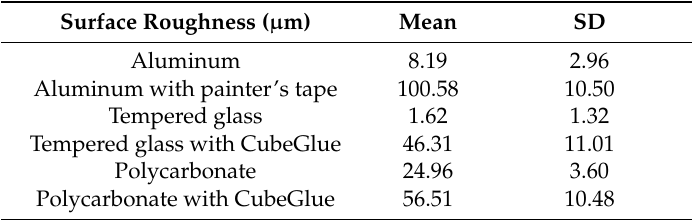
Figure 5. Results of the build plate surface profile characterization study, where ( a , b ) show the surface roughness of untreated plates and ( a , c ) show the roughness of the epoxy-treated surfaces. Table 2. Summary of build plate surface profile study. Table 2. Summary of build plate surface profile